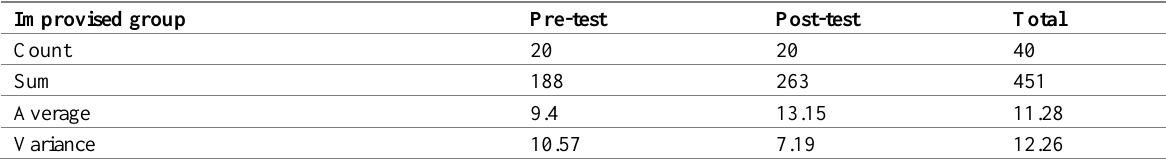
Table 2: Summary of Results for The Improvised Group